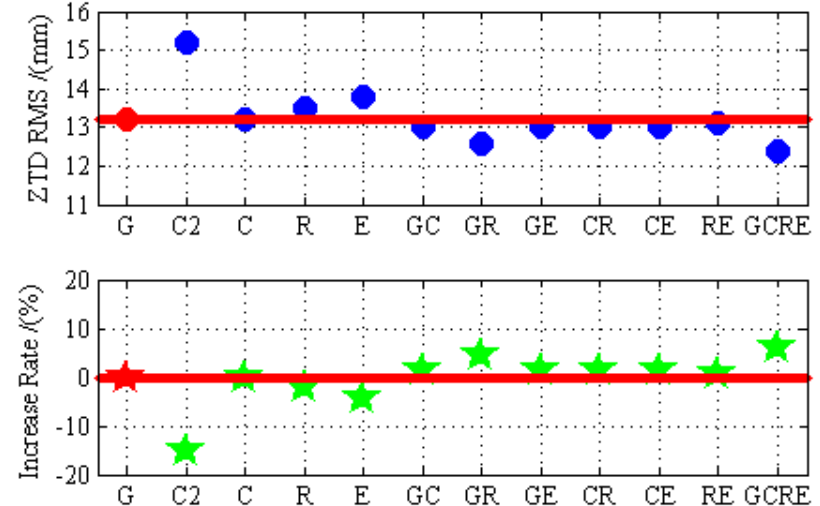
Figure 12. The absolute ZTD differences between ZTD values estimated using PPP and iGMAS ZTD at BRCH for 12 different processing cases on DOY 024 in 2019.